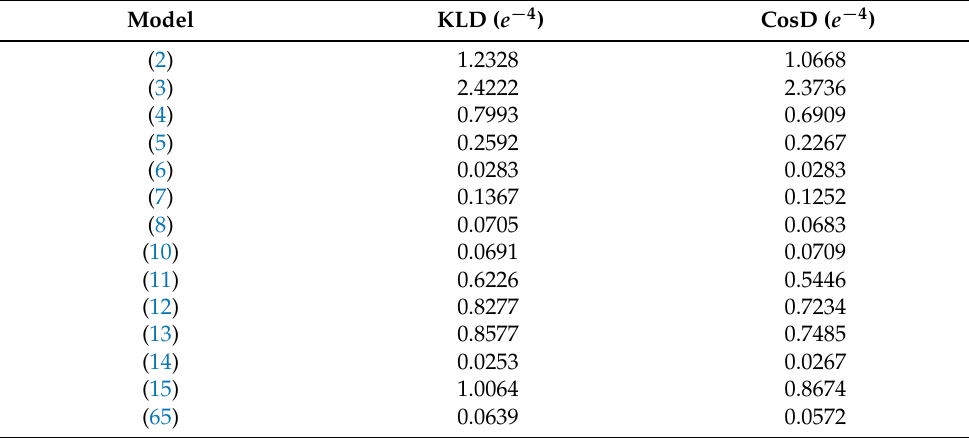
Table 7. Numerical Stability